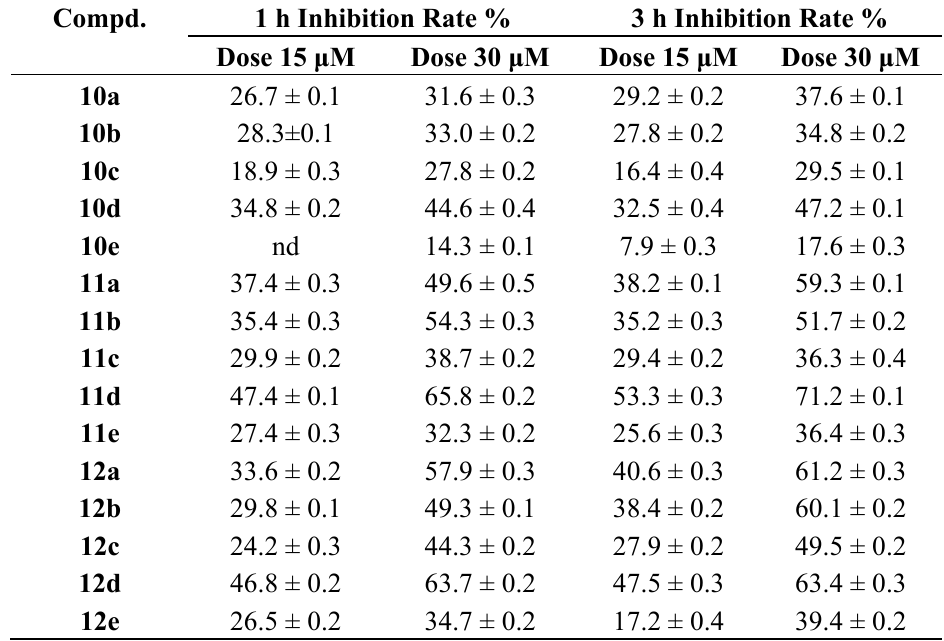
Table 2. The inhibitory effects of compounds on adhesion of HUVEC on collagen at a dose of 15 μ M and 30 μ